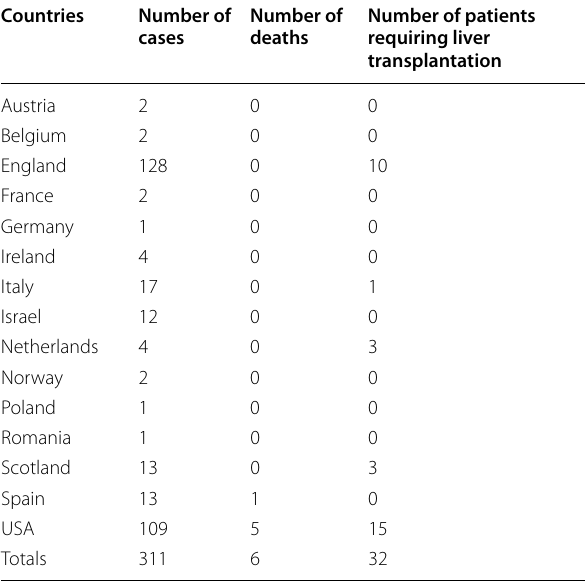
Table 1 Overview of cases of the number of unknown hepatitis cases and their need for liver transplantation until the 27th